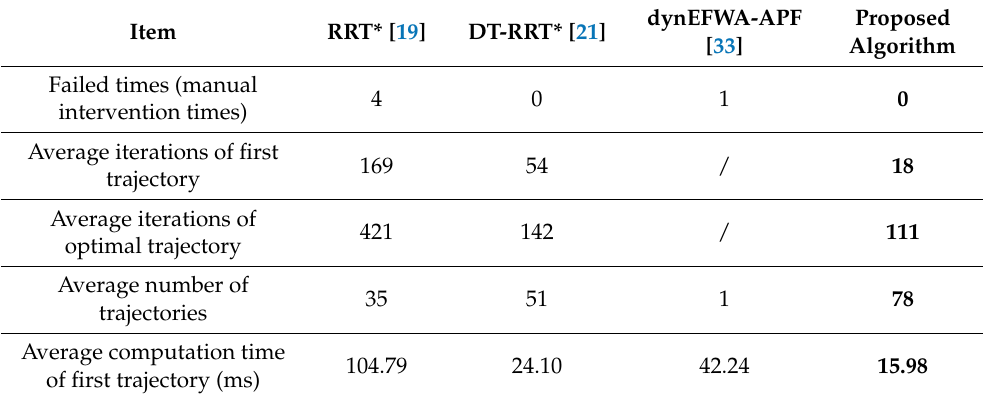
Table 9. Performance comparison with three motion planning algorithms in the algorithm effi- ciency